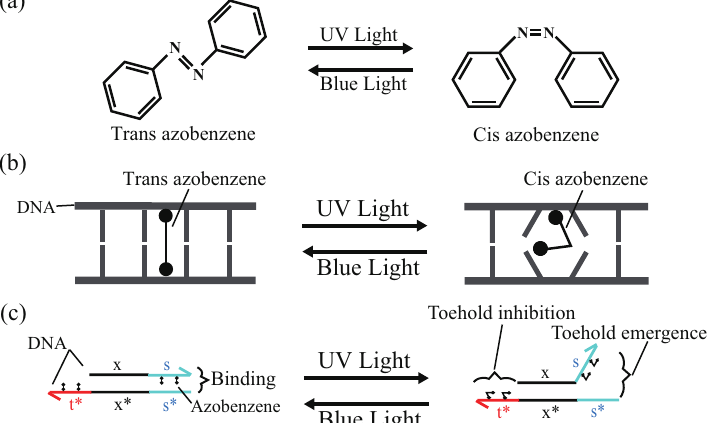
Figure 3. Photoisomerization of azobenzene and the effect of attachment to DNA. ( a ) Photoisomeriza- tion of azobenzene; ( b ) effect of azobenzene attachment on base pairing; and ( c ) effect of azobenzene attachment on DNA domain. The black line, x, indicates a long domain (recognition domain) of more than 15 nt, while the non-black-colored lines, t, and s, indicate short domains (toehold domain) of 1 ∼ 10 nt. In addition, x and x ∗ and s and s ∗ represent complementary DNAs,